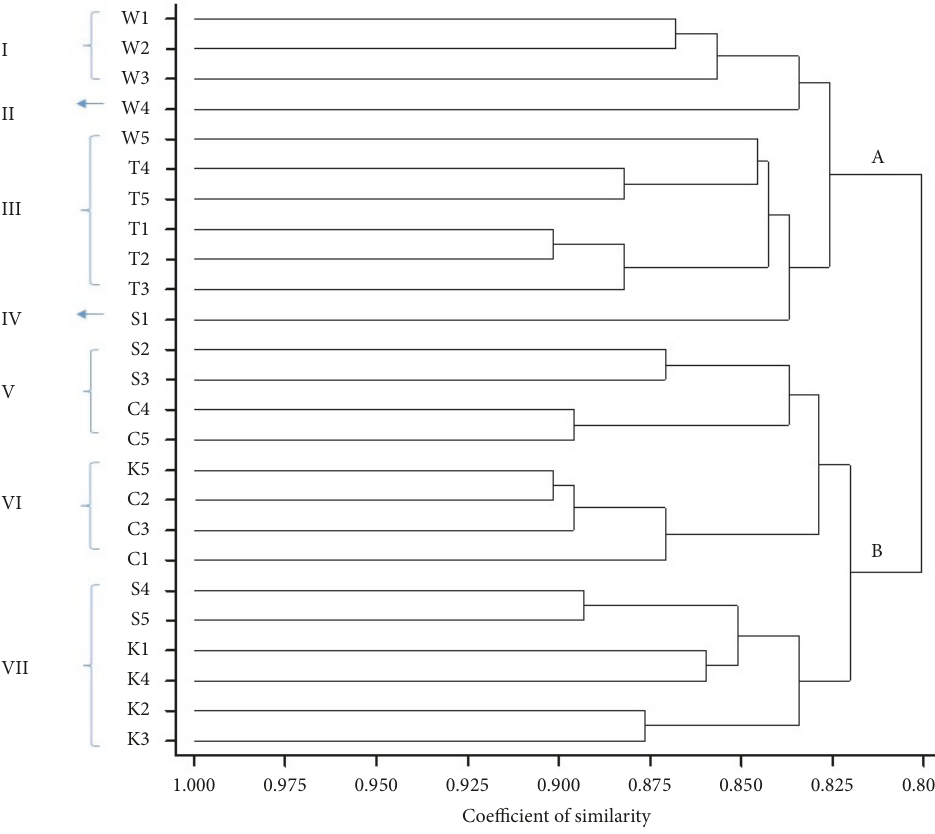
Figure 3: Dendrogram of 25 sesame accessions screened with 21 SSR markers using complete link Euclidean cluster